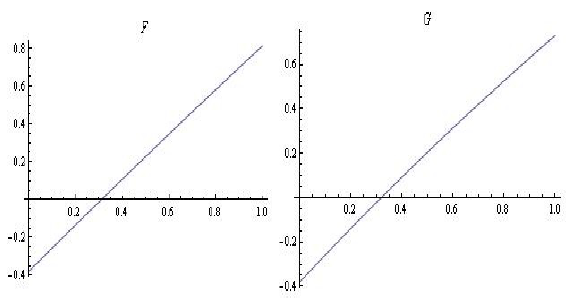
Fig. 2. The functions F ( d ) and G ( d )